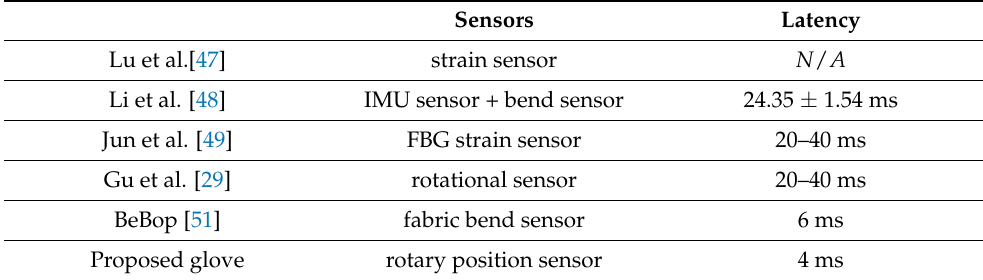
Table 5. Comparison of Latency with other methods found in the